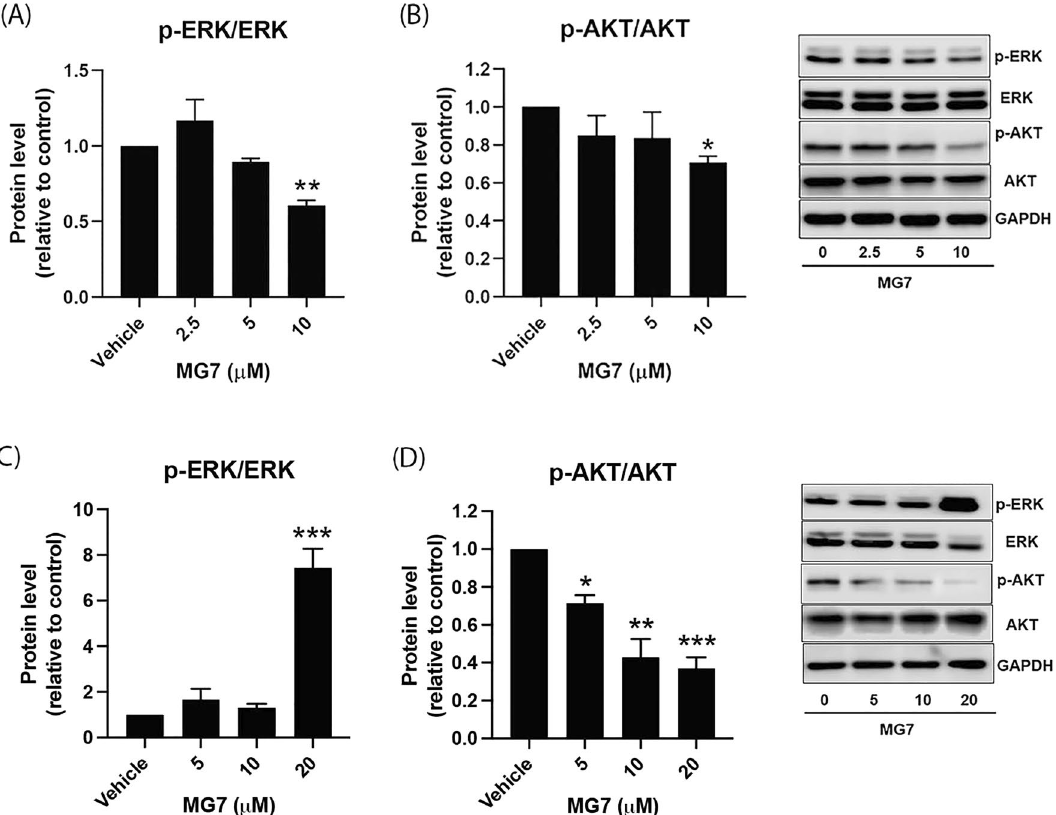
Figure 9. Effects of MG7 on ERK/MAPK and PI3K/AKT signaling pathways in HCT-116 and HT29 cells. The expression ratio of phosphorylated ERK to total ERK and phosphorylated AKT to total AKT in ( A , B ) HCT-116 and ( C , D ) HT-29 cells after being treated with MG7 at indicated concentrations for 24 h were determined using western blot. * P < 0.05, ** P < 0.01 and *** P < 0.001 compared to vehicle control (0.2%